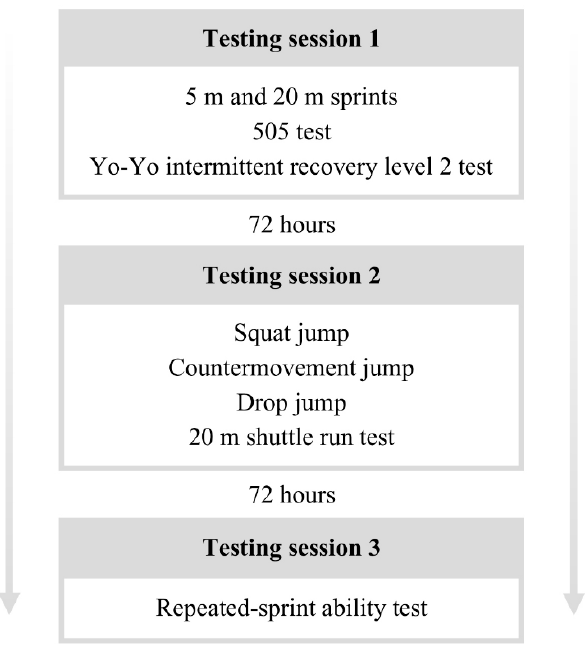
Figure 1. Testing protocol.